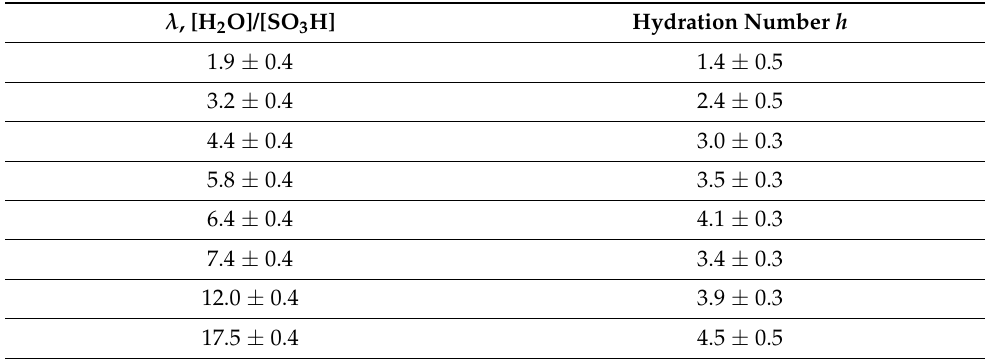
Table 3. Hydration number h at different absolute amount of water molecules per ionic site SO 3 − ( λ ) in acidic form Nafion 117 membrane